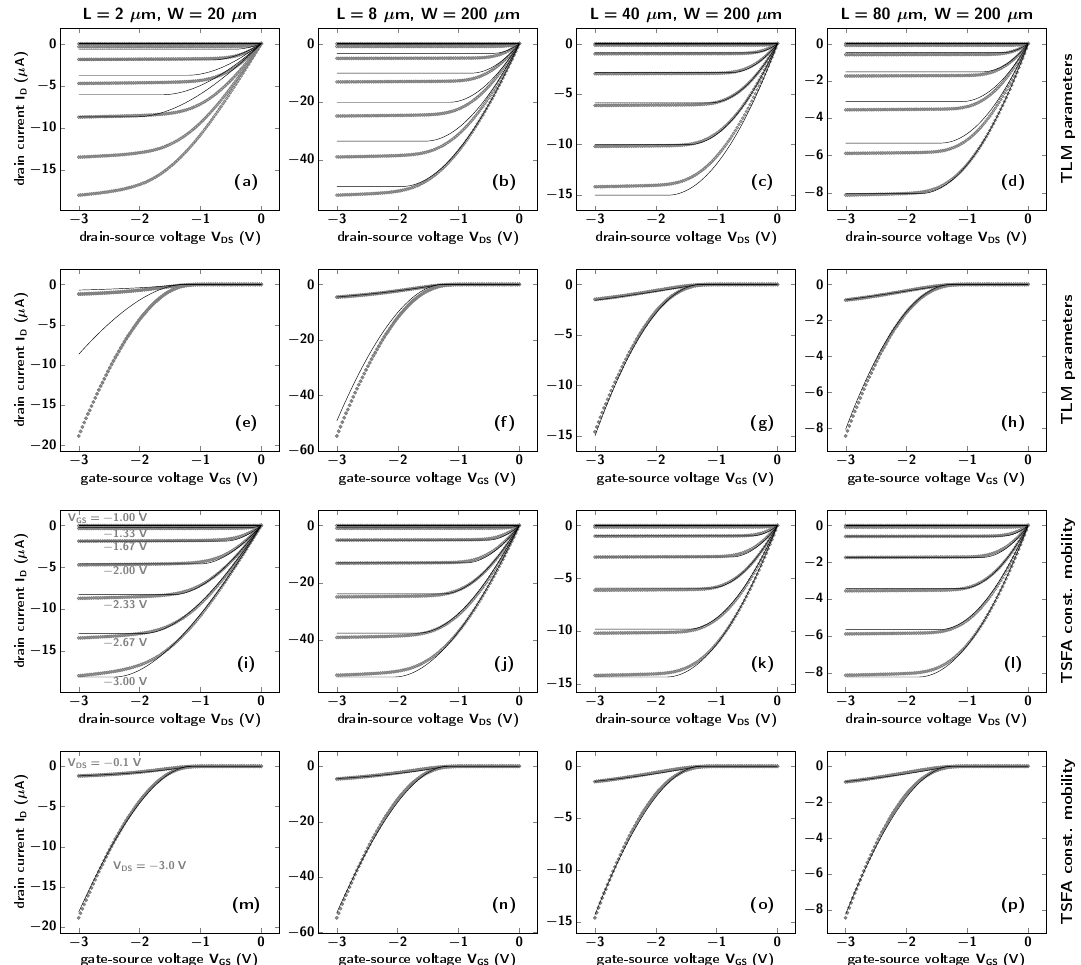
Figure 3. Measured output and transfer characteristics (gray symbols) and calculated output and transfer characteristics (black lines) of bottom-gate, bottom-contact DNTT TFTs with channel lengths L of 2, 8, 40, and 80 µ m. The TFT with a channel length of 2 µ m has a channel width of 20 µ m, while the TFTs with channel lengths of 8, 40, and 80 µ m have a channel width of 200 µ m. Note that the gray symbols appear as an apparent thick line due to the close spacing of the data points. In ( a – h ), the output and transfer curves were calculated using the transistor parameters extracted using the conventional TLM analysis. In ( i – p ), the output and transfer curves were calculated using our two-step fitting approach (TSFA) with the constant-mobility model underlying the conventional TLM. As we are able to calculate the electrical TFT characteristics for a given set of device